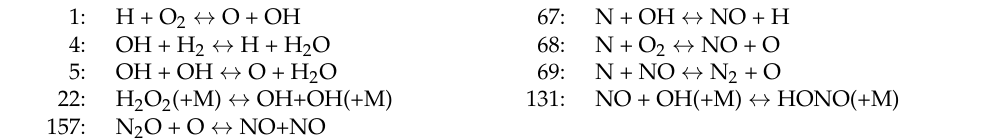
Figure 3. Diagnostic points identified on NO mass fraction profile; autoignition of pure NH 3 /air. Table 2. The reactions most influencing the slow chemical dynamics related to NO